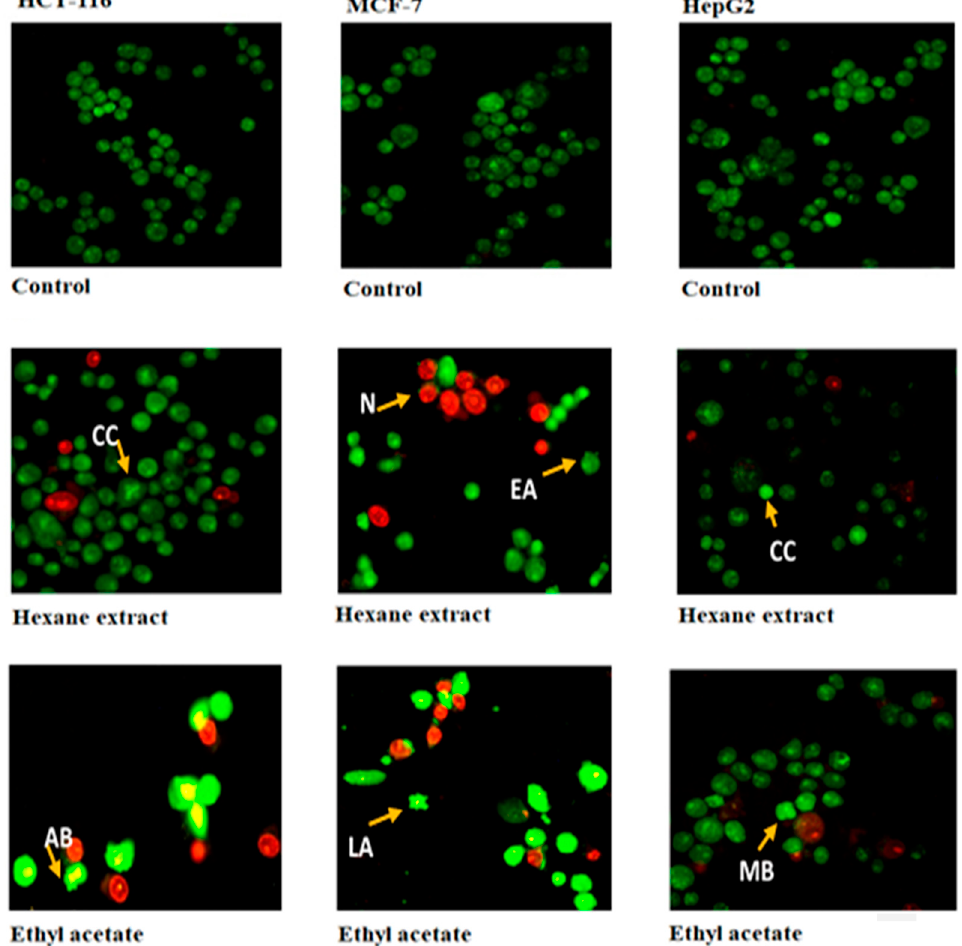
Figure 2. Morphological changes of HCT-116, MCF-7, and HepG2 cells induced by the IC 50 concentration of hexane and ethyl acetate extracts of A. lagopoides for 48 h, stained with AO/EB. The images were taken using fluorescence microscopy at 20 × . MB: membrane blebbing; CC: chromatin condensation; EA: early apoptosis; LA: late apoptosis; AB: an apoptotic body; N: necrosis. Scale bar: 2 µm.